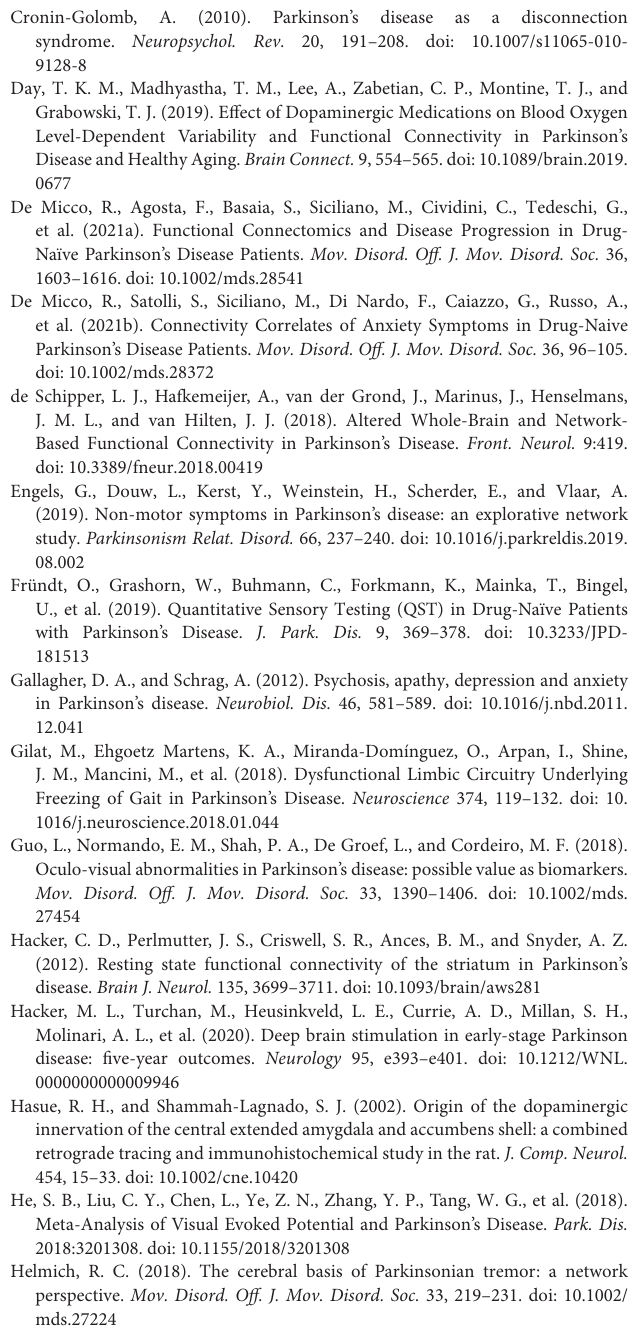
histogram compares significantly decreased inter-network connections between the PD and HC groups; the y-axis represents the inter-network functional connectivity strength. (D) Two hundred twenty-one widely distributed connectivity pairs are shown (all p < 0.05, FDR corrected). The same color of spheres represented ROIs were from the same RSNs. Asterisks indicate significant group differences ( ∗ p < 0.05, ∗∗ p < 0.01, ∗∗∗ p < 0.001). PD, Parkinson’s disease; HC, healthy control; ROIs, regions of interest; RSNs, resting-state network; VSN, visual network; SMN, somatomotor network; DAN, dorsal attention network; VAN, ventral attention network; LBN, limbic network; FPN, frontoparietal network; DMN, default mode network; DGN, deep gray matter network; FDR, false discovery